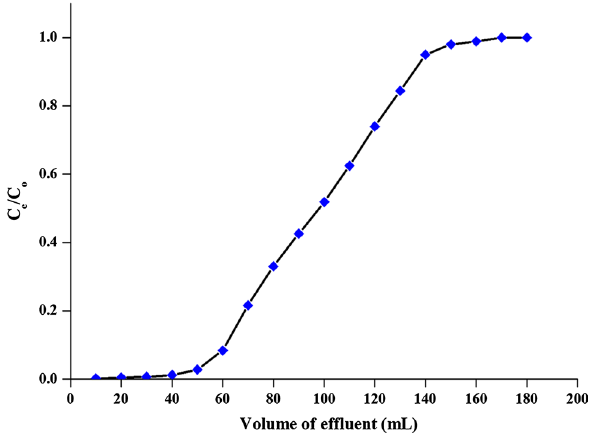
Fig. 15 Regeneration of PGADP by batch mode (conditions; adsor- bent = 0.025 g; CV = 20 mgL −1 ; cycles =